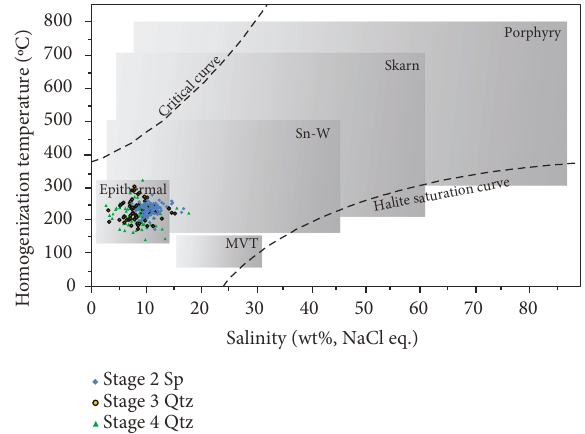
Figure 13: Diagram of homogenization temperature versus salinity for the fl uid inclusions at the Keyue Sb – Pb – Zn – Ag deposit (modi fi ed from Wilkinson